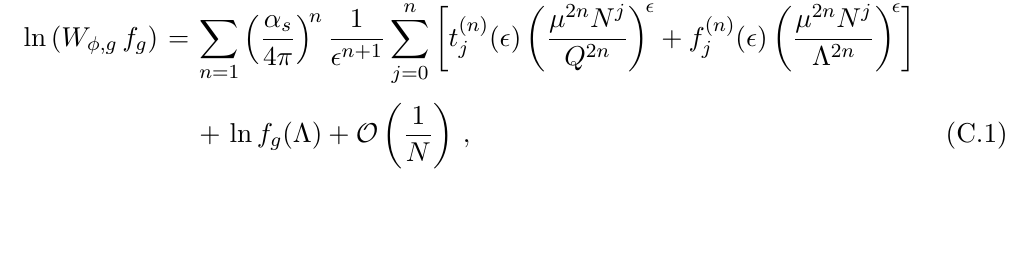
table 1. The energetic parton scattering o(cid:11) the Higgs boson (or virtual photon in